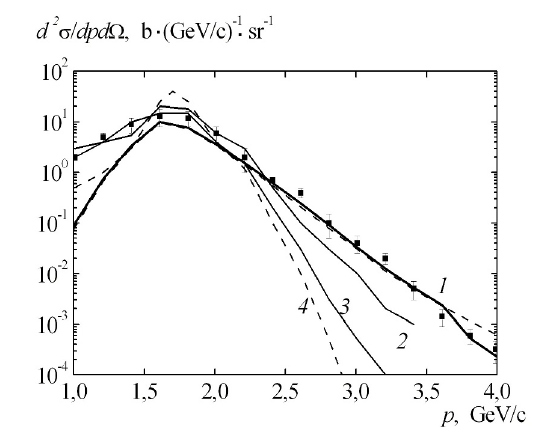
Figure 5. The same as in Fig. 3 with the 12 C ion energy of 950 MeV / nucleon, and < T h > ≈ 51 MeV, < µ T > ≈ -37